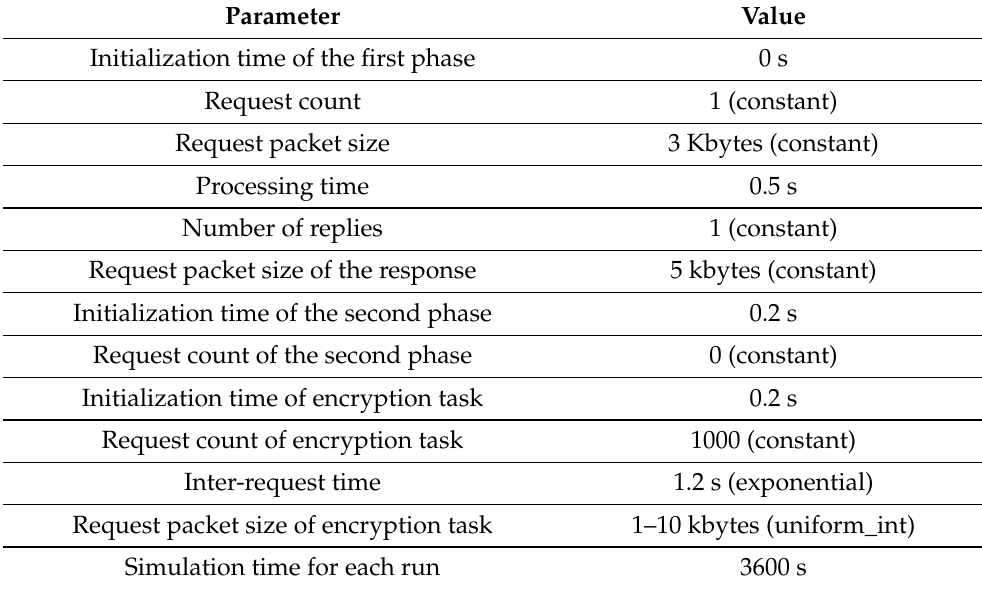
Table 2. Simulation parameters. Parameter